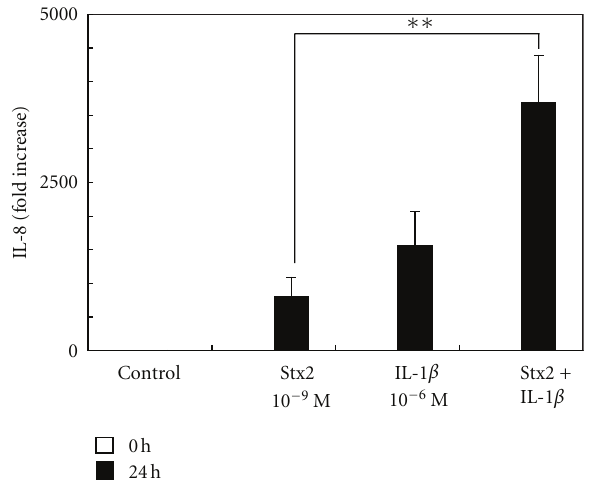
Figure 5: Expression of IL-8 mRNA in HASTs upon stimulation with Stx2 and IL-1 β . Expression of IL-8 mRNA was examined by real-time quantitative PCR using HASTs treated with 10 − 9 mol/L Stx2 and 10 − 6 mol/L IL-1 β for 24 h. The levels of induction of IL- 8 mRNA expression were calculated relative to those of the control cultures, which had not been treated with Stx2 or IL-1 β . Data are expressed as fold increases of mRNA expression (mean ± SD from five independent experiments). Comparisons between the levels of IL-8 mRNA elicited by treatment with 10 − 9 mol/L Stx2 alone and those elicited with 10 − 9 mol/L Stx2 and 10 − 6 mol/L IL-1 β are shown. Induction of IL-8 mRNA upon stimulation with 10 − 9 mol/L Stx2 and 10 − 6 mol/L IL-1 β in combination at 24 h was significantly elevated ( P < 0 . 01) in comparison with that elicited by either 10 − 9 mol/L Stx2 or 10 − 6 mol/L IL-1 β alone. ∗∗ P < 0 .